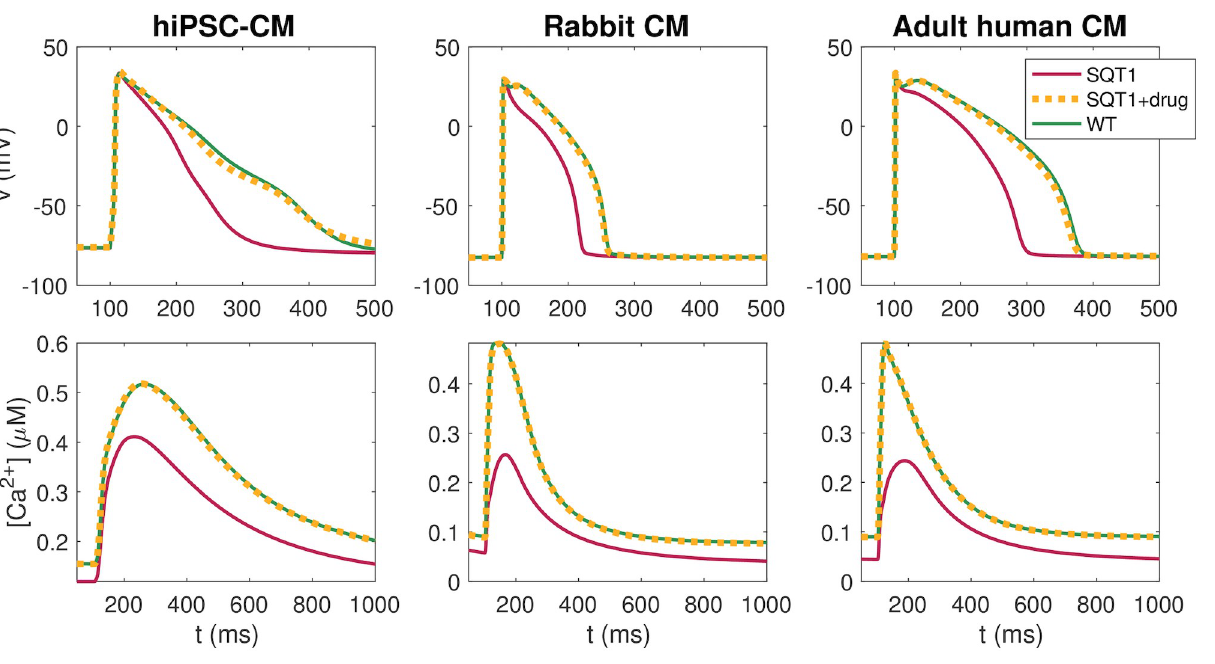
Fig 7. AP and Ca 2+ transient waveforms for hiPSC-CMs, rabbit ventricular CMs and adult human ventricular CMs in the wild type case (solid green), in the SQT1 case (solid red), and in the SQT1 case with the optimal combination of five drugs with the restriction D � min(EC 50 )/2 from Fig 6 applied (dotted yellow). Data used in this figure can be found in S1